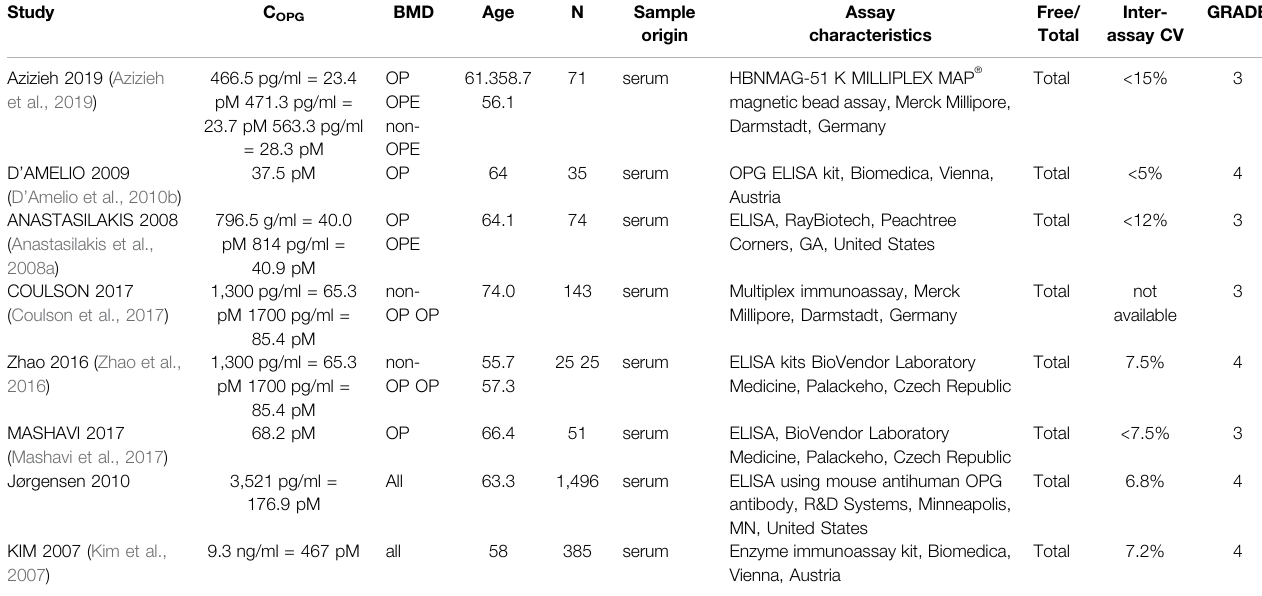
( Table 6 ), C sclerostin ( Table 7 ), and C TGF- β ( Table 8 ) to account for differences in measurement technique. Note that RANKL